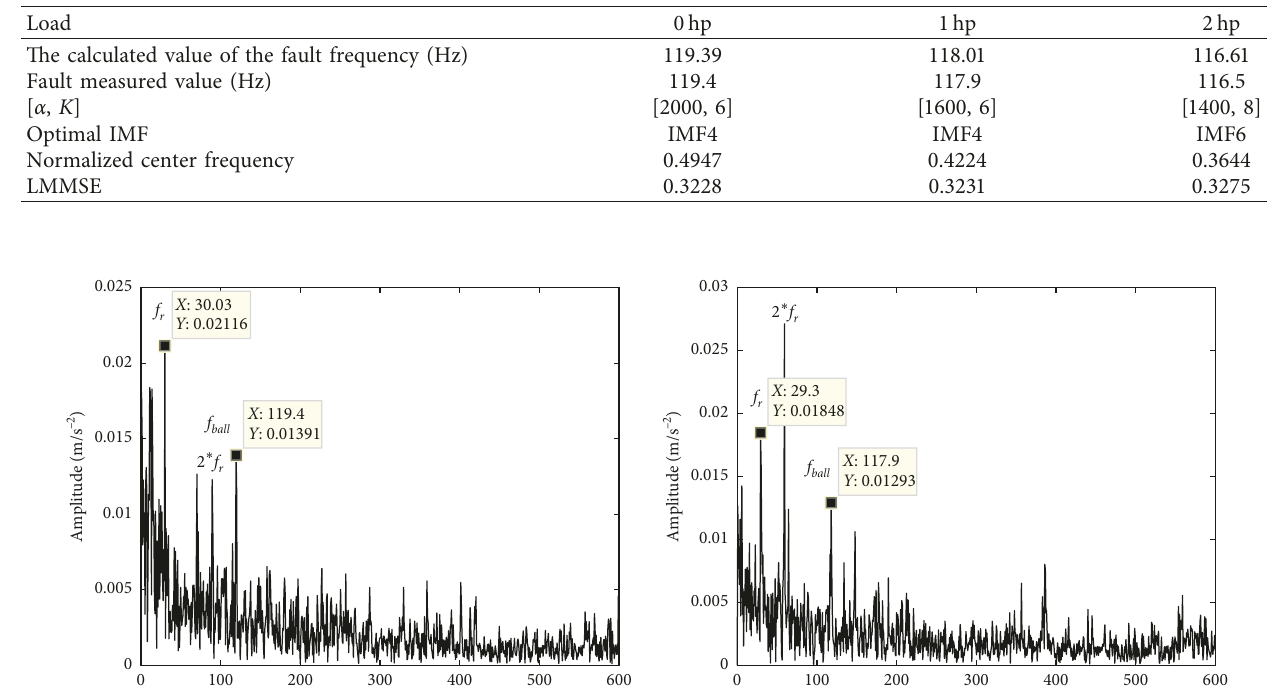
Table 2: Optimal search results.